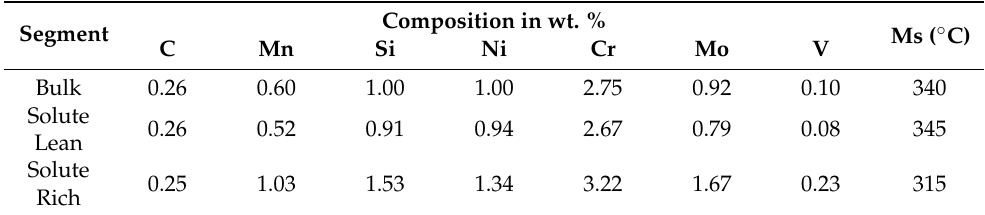
Table 1. Composition (in wt. %) of the bulk, solute rich (Last 15%) and solute lean (First 85%) regions as